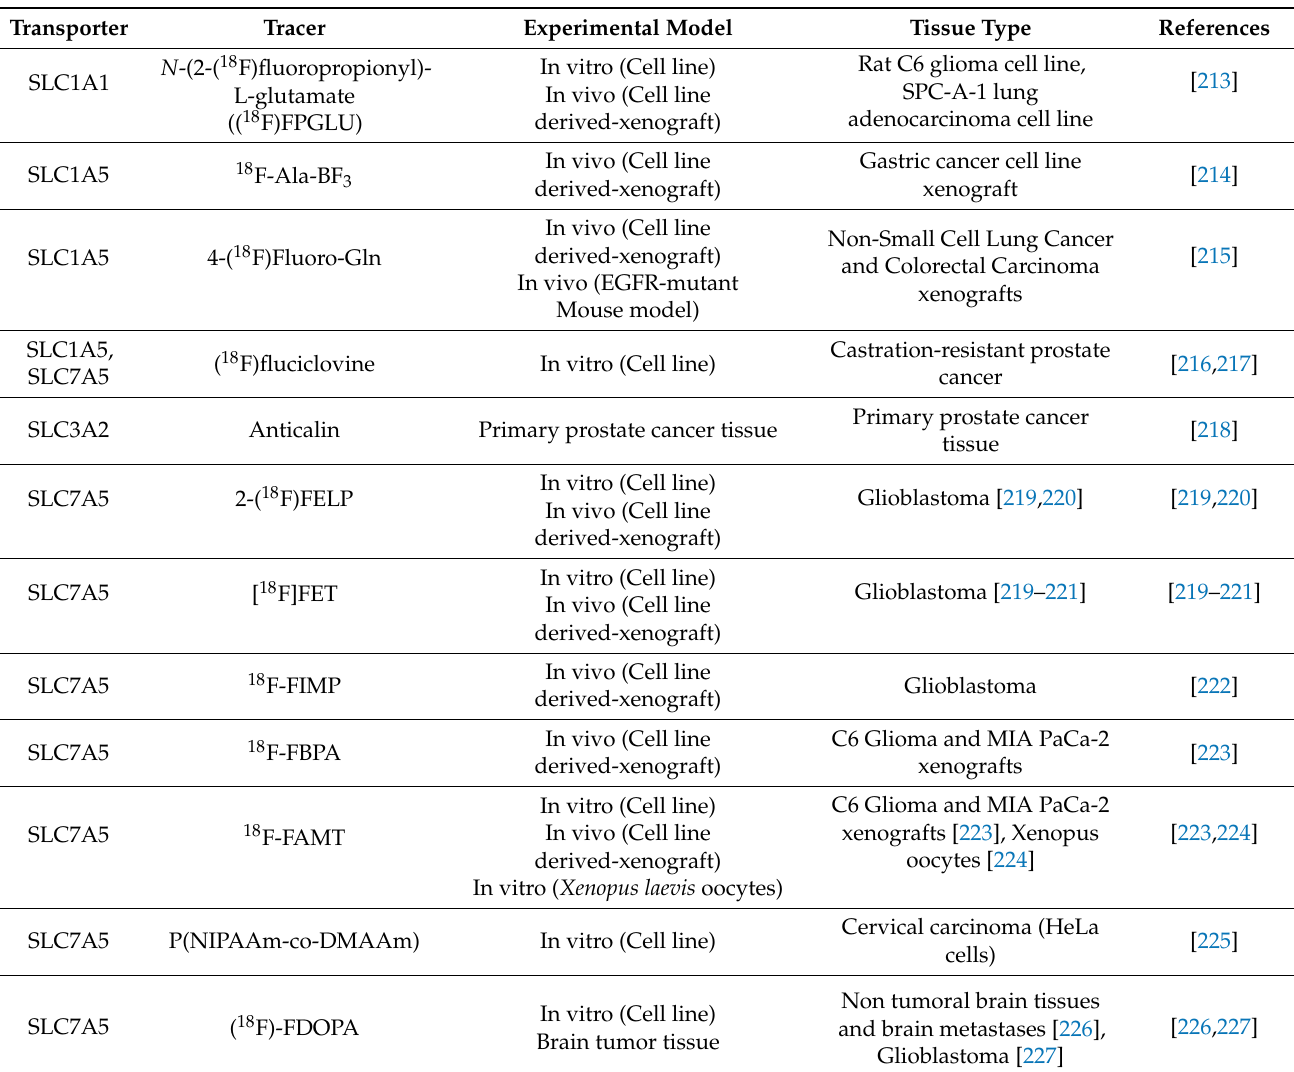
Table 2. Molecular imaging by using amino acid